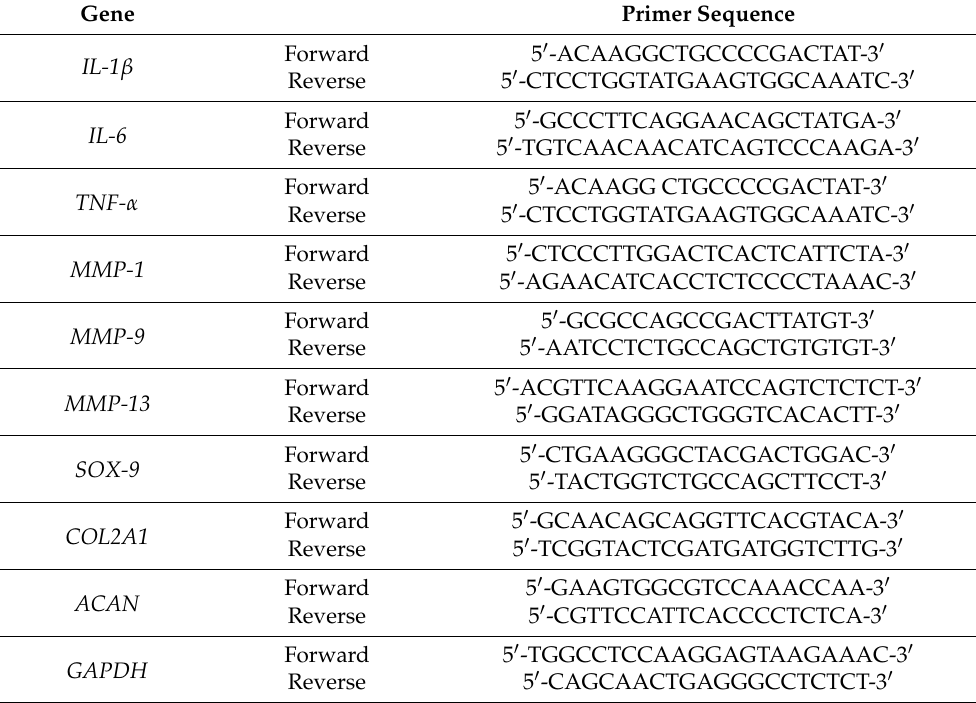
Table 1. Primer sequences used for the mRNA expression analyses.